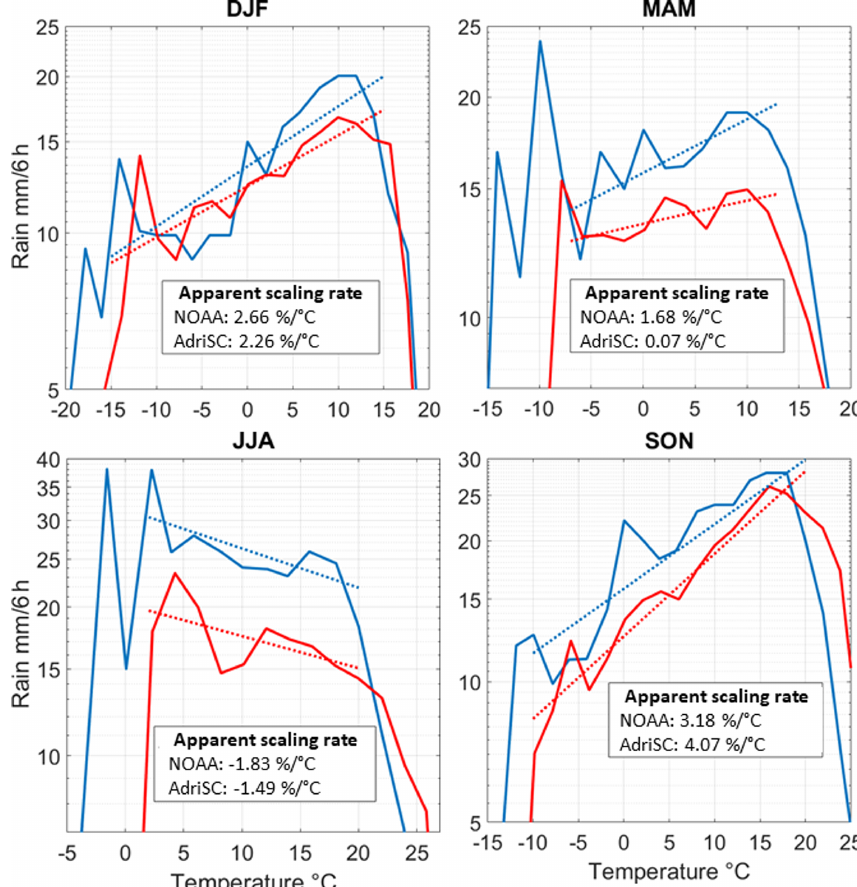
Figure 18. Seasonal apparent scaling rates derived for both the AdriSC WRF 3km model (i.e. AdriSC, in red) and the observations (i.e. NOAA, in blue) from the dataset of the 251 NOAA stations and defined as the linear relationship between the logarithm of the extreme precipitation (i.e. 99th percentile) and the 2m